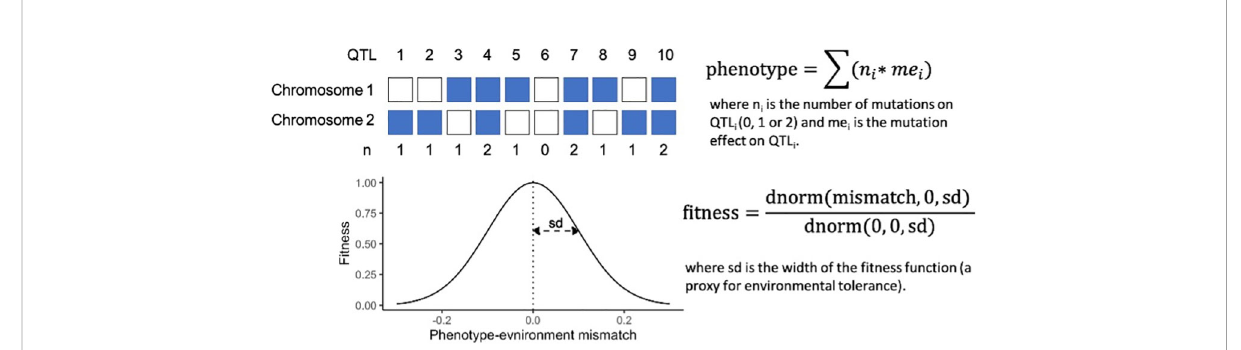
FIGURE 2 A mechanistic approach to QTL-based phenotype and fi tness calculations, with a schematic for 10